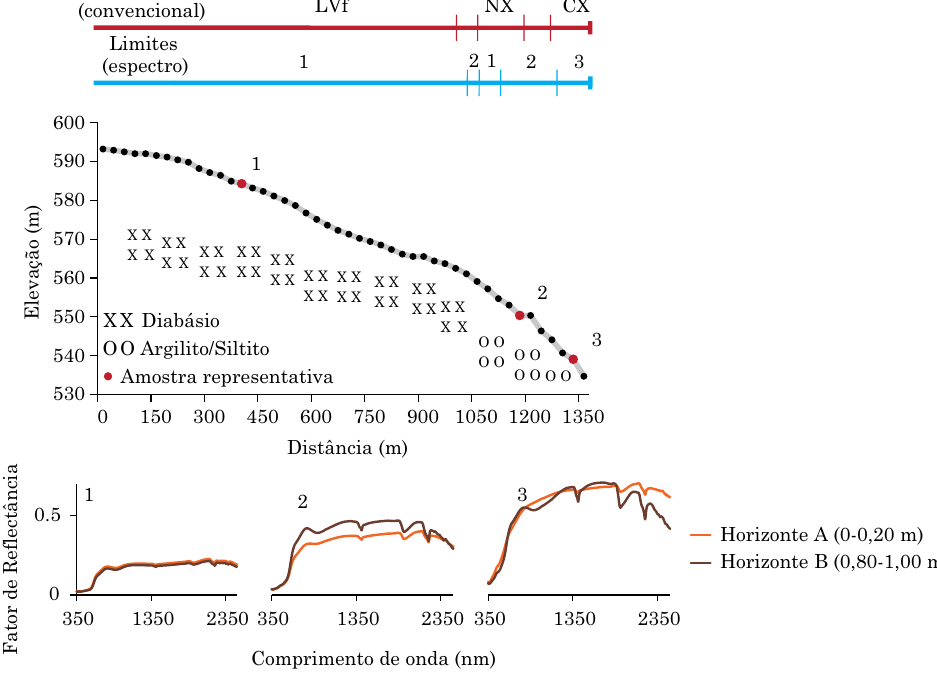
Figura 4. topossequência C e limites de classes de solos determinados por métodos convencional e espectral. os pontos 1, 2, e 3 correspondem às amostras representativas às suas unidades espectrais (pontos em vermelho), evidenciando as curvas espectrais dos horizontes a e B.